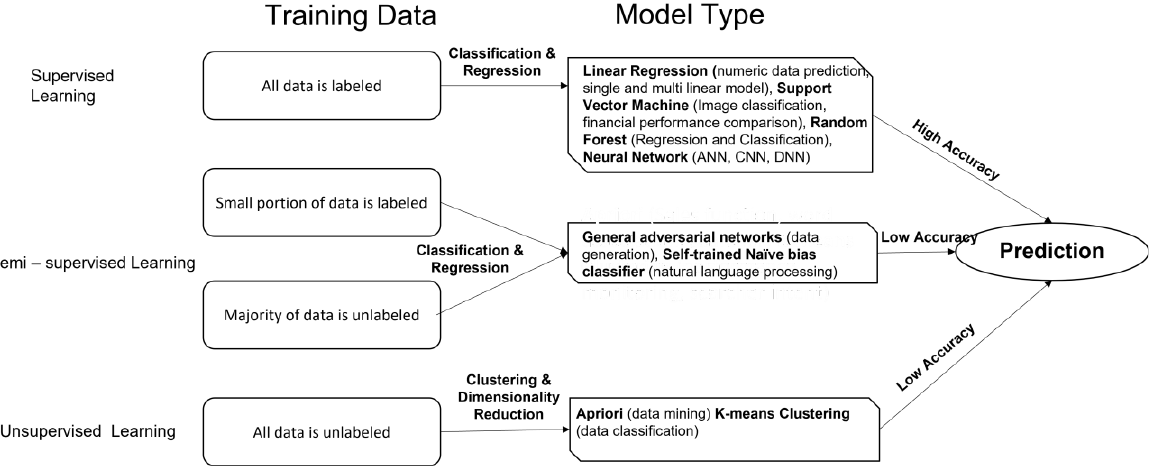
Figure 1. Summary of supervised, semi-supervised, and unsupervised models of machine learn- ing